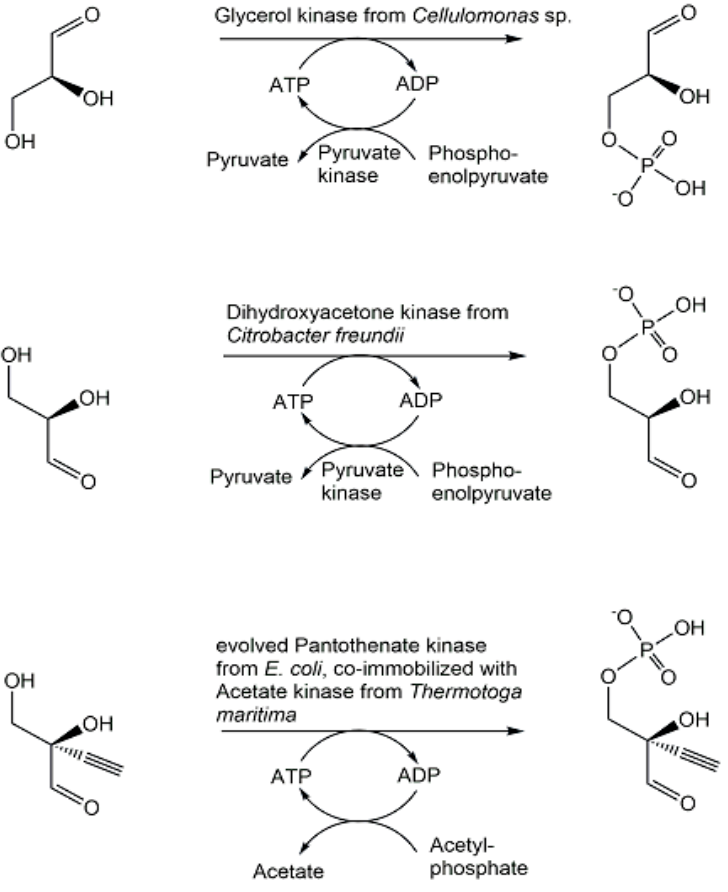
Figure 17. Enzymatic synthesis of phosphorylated chiral glyceraldehydes. Chiral phosphohydroxycarboxylic acids are important phosphometabolites in glycolytic, mevalonate, and shikimate pathways. The glycolysis intermediate D-glycerate 2-phosphate was prepared with high purity and good yield by glycerate 2-kinase-catalyzed phosphorylation of D-glycerate [120]. The classical mevalonate pathway intermediate ( R )-mevalonate 5-phosphate (see Figure 14) has been also been synthesized with high purity and good yield by mevalonate 5-kinase-catalyzed phosphorylation (see Figure